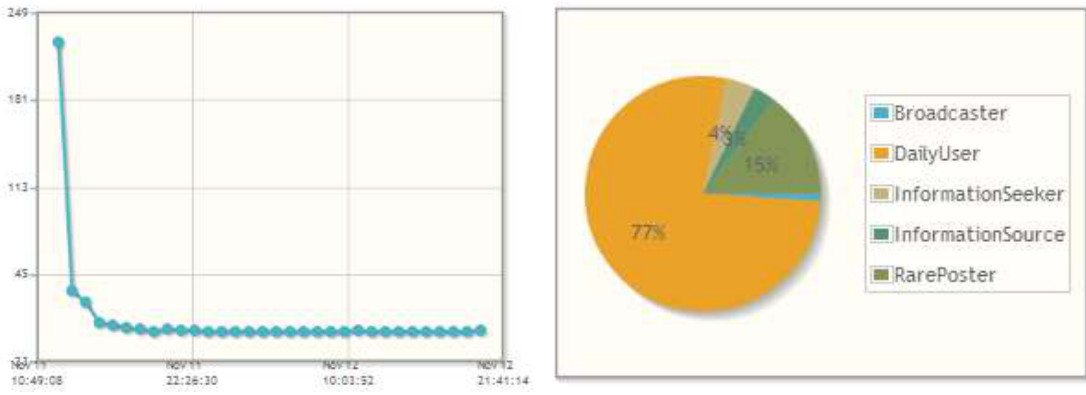
Figure 10: WeGov Analysis Components – Frequency of Posts (Cp. left) and User Roles (Cp.